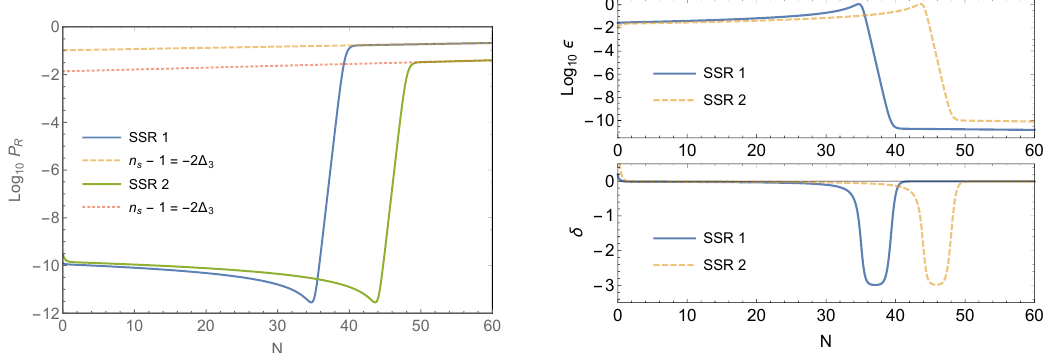
Figure 6 . The power spectrum P R of the secondary slow-rolling (SSR) class with the transition from δ < 0 to δ ≈ 0 . H ∗ = 8 × 10 − 6 M pl is used in this plot. The dotted lines are fitted power spectra with the spectral index given by n s − 1 = − 2∆ 3 , where ∆ 3 = ∆( N = 60) is used. tial value φ = 18 M for SSR 1. For SSR 2, we choose { α 0 pl